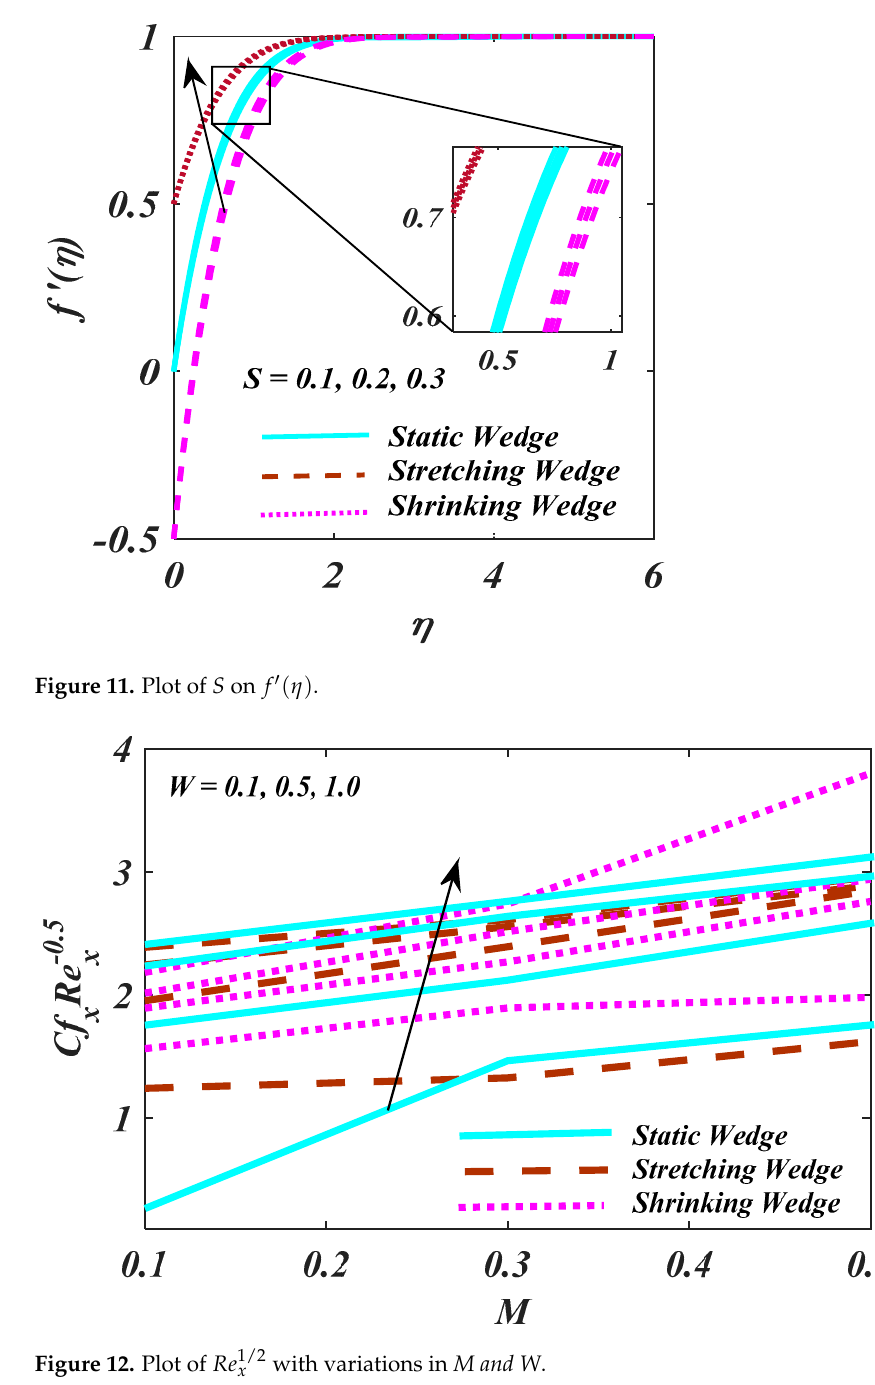
Figure 10. Plot of (cid:1838)(cid:1854) on (cid:1840)(cid:4666)(cid:2015)(cid:4667).